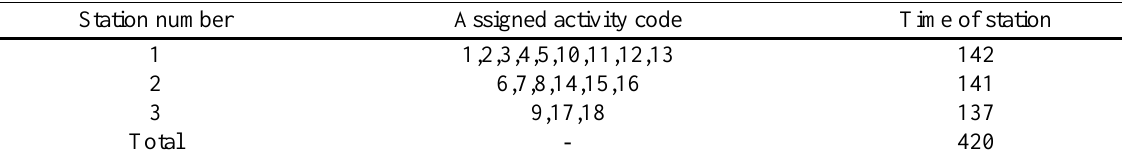
Table 6. Suggested workstations according to the proposed model of the article.